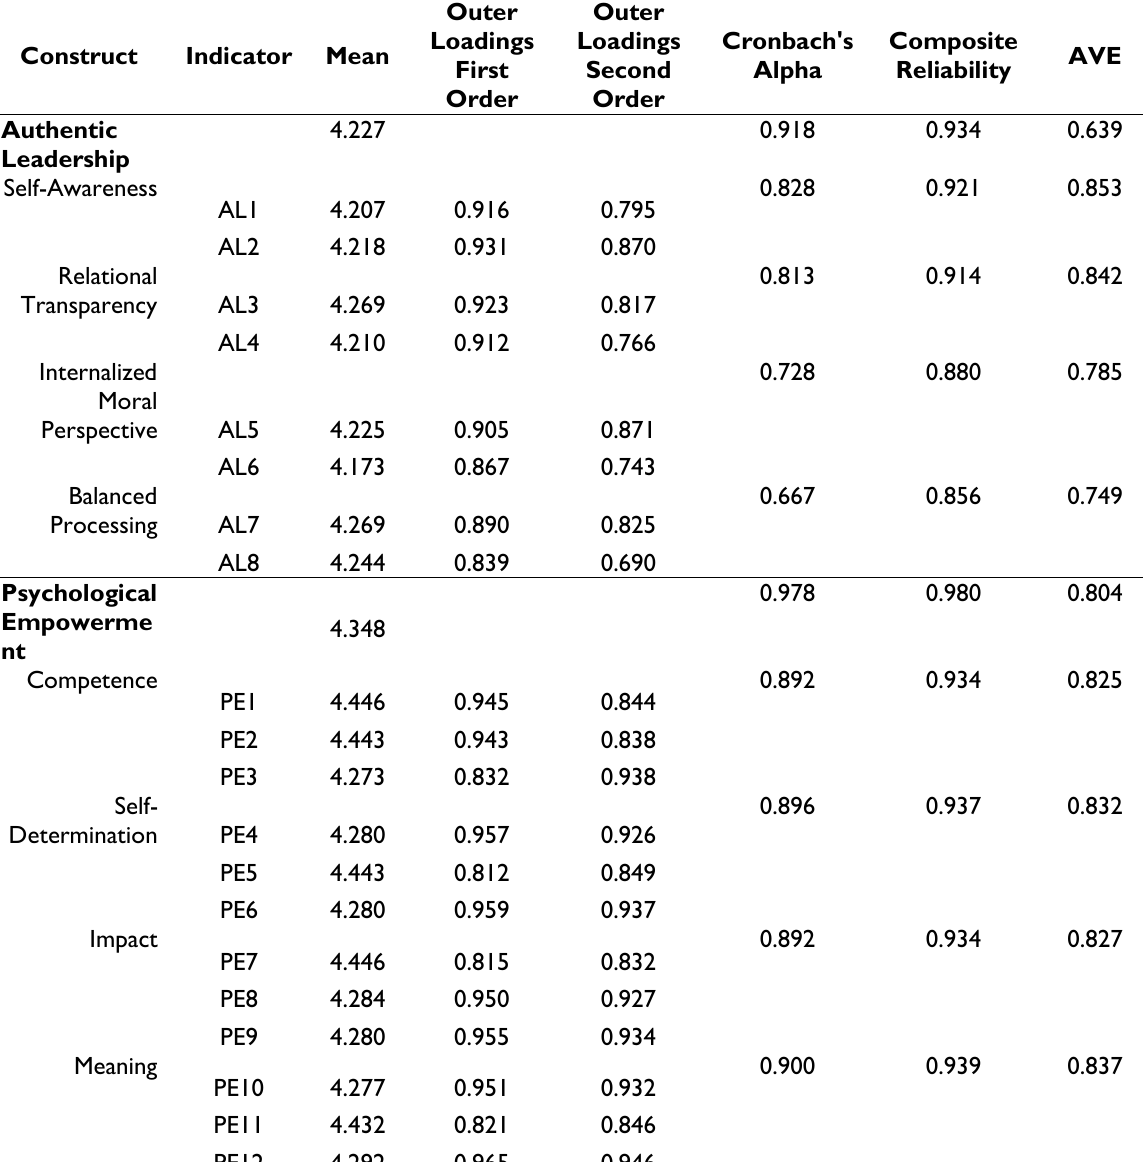
Table 2. Measurement